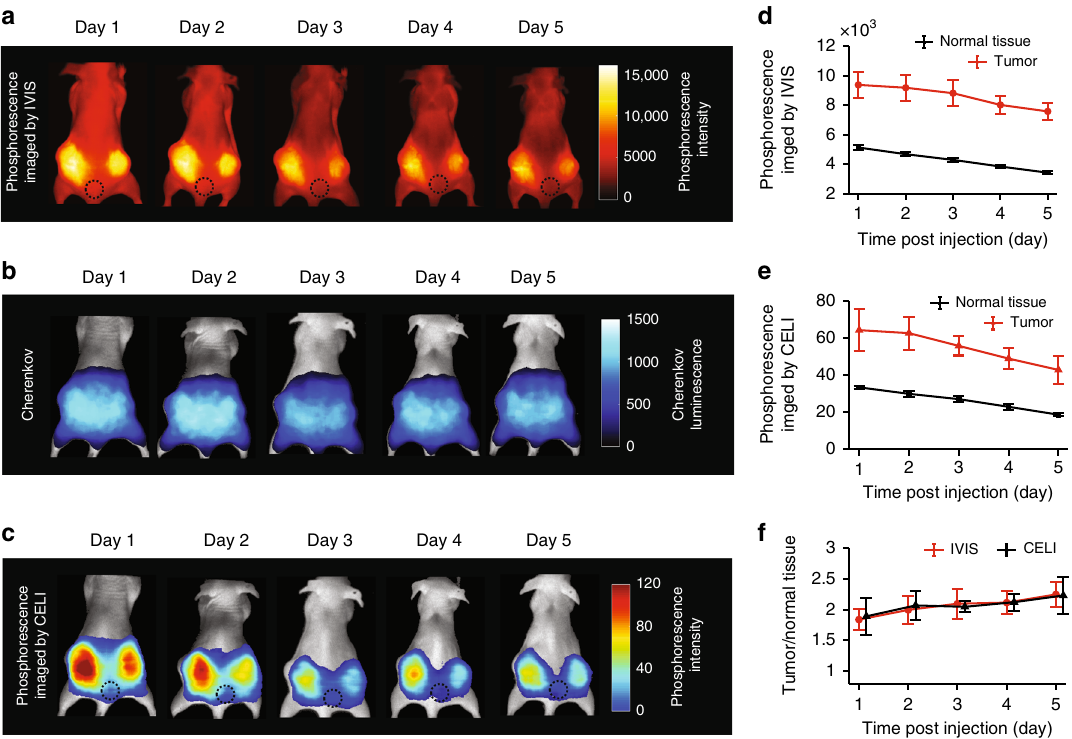
Fig. 2 Longitudinal in vivo imaging of phosphorescence during 5 days after a single IV injection of Oxyphor PtG4. a Phosphorescence intensity images measured using wide- fi eld optical excitation in a standard IVIS instrument. b Integrated intensity images of the Cherenkov light along with the phosphorescence of Oxyphor PtG4, acquired during the time of the radiation delivery. c Phosphorescence intensity images by CELI. Average intensity of the phosphorescence acquired by IVIS ( d ) and CELI ( e ) for the tumor area and for the normal tissue ( n = 4). f The ratio of the signals tumor:normal tissue as imaged by IVIS and CELI ( n = 4). Error bars represent standard error of the